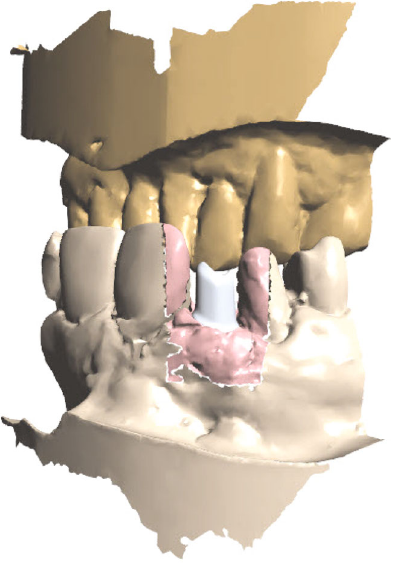
Figure 15: Design of the abutment/crown construction using 3Shape Dental Manager. Plaster model with the stationary scanner D2000 (3Shape, Trios). Lateral view.